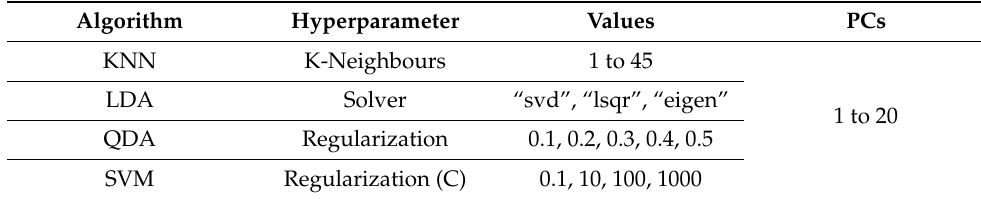
Table 3. Hyperparameter tested for the classification